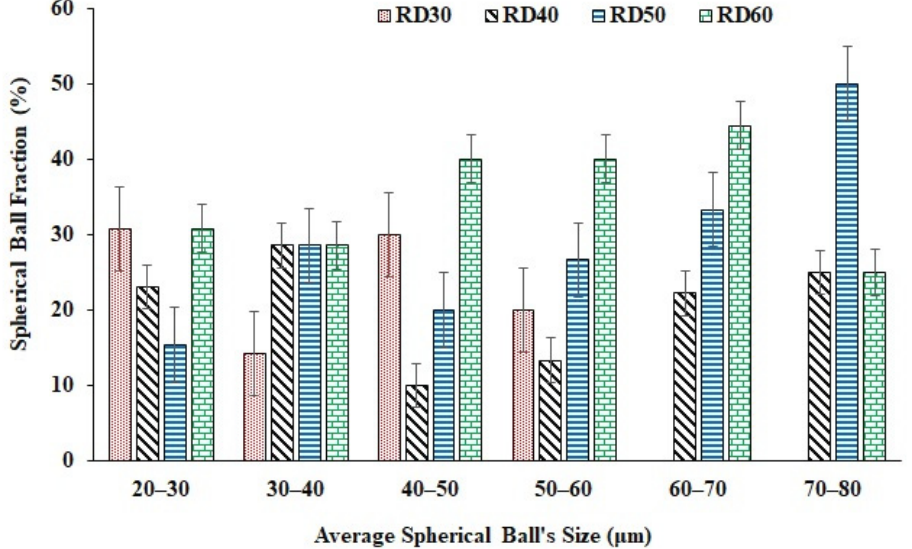
Figure 6. LBPF-manufactured samples showed the formation of spherical balls. The bar chart shows the distribution of average particle sizes of the spherical balls formed as a function of relative den-